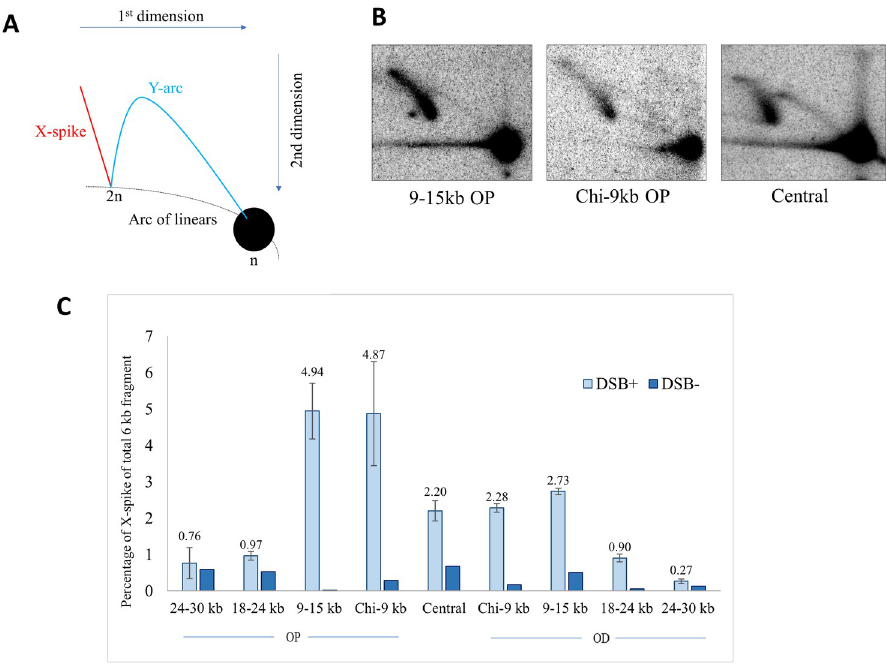
Fig 2. Distribution of Holliday junction DNA structures across the lacZ region of Δ ruvAB mutant strains as a function of induction of DSB repair. A) Schematic diagram of a native-native 2-D electrophoresis gel showing the expected migration pattern of 3-way (Y-arc) and 4-way (X-spike) DNA structures denoted by blue and red lines, respectively. n represents linear, un-replicated DNA while 2n represents linear, replicated DNA. B) 2-D gels of the crosslinked 9-15kb OP, Chi-9kb OP and central fragments for Δ ruvAB strains (DL7259, DL7253 and DL7272, respectively) containing the palindrome, grown in the presence of 0.2% arabinose for 60 minutes. C) Quantification of the signal intensities of HJs generated across the 60kb region following a DSB. The HJ quantification was done on crosslinked DNA samples and is presented as a percentage of X-spike out of the total 6kb DNA fragment (DSB + ). The quantification of X-spikes from control blots (2-D gel analysis of crosslinked DNA fragments isolated from cell cultures grown in presence of glucose to repress the expression of sbcDC is also shown (DSB - ). The strains used were DL7271 ( Δ ruvAB 24-30kb OP), DL7270 ( Δ ruvAB 18-24kb OP), DL7259 ( Δ ruvAB 9-15kb OP), DL7253( Δ ruvAB Chi- 9kb OP), DL7272 ( Δ ruvAB Chi-Chi), DL7251 ( Δ ruvAB Chi-9kb OD), DL7258 ( Δ ruvAB 9-15kb OD), DL7261 ( Δ ruvAB 18-24kb OD) and DL7262 ( Δ ruvAB 24-30kb OD). OP and OD represent origin-proximal and origin-distal sides. Error bars represent the standard error of the mean where the number of replicates is 3 for the DSB + strains. The experiments on DSB - strains were done